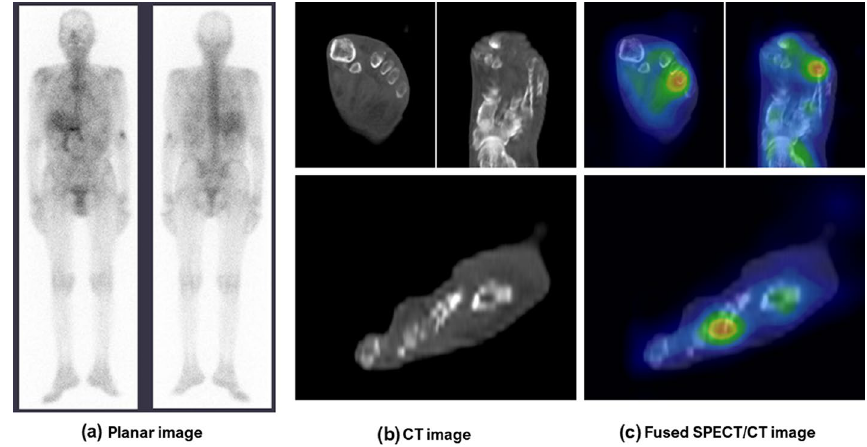
Fig. 2 These images represent a 68-year-old man who developed a fever and increased inflammatory markers after treatment for leg trauma, with dyslipidemia, stable angina, and atherosclerosis obliterans as comorbidities. a shows Ga-scintigraphy, whole-body, planar images indicating a defect in the left toes with no clear signs of accumulation. b shows CT images indicating a resection of the left toes and cellulitis near the left 4th distal phalanx with irregular bone destruction, and increased attenuation lesions in the subcutaneous soft tissue. c shows fused SPECT/CT images indicating distinct accumulation in the left 4th distal metatarsal and proximal phalanx with low LBR (5.40), SUVmax (3.25), and TLU (35.02). Recovery from fever and inflammation was smooth, not requiring surgical treatment, but localized pain remained for a few months. The clinical diagnoses of CE and LLOM were established by the primary physicians according to the clinical progress and outcomes. This patient had no MAE within the 3-year observation period